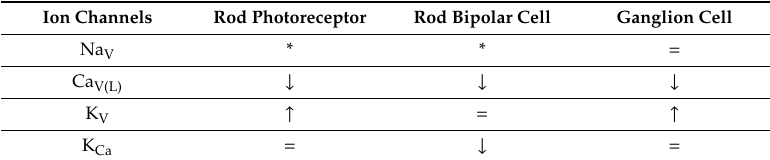
Table 1. Ion channels and their modulation by somatostatin ( ↑ : potentiation; ↓ : reduction; = no e ff ect) in the retinal cells of the information transmission line RP → RBC →